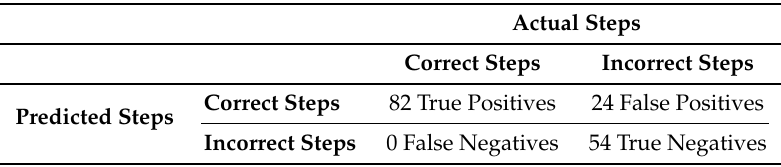
Table 2. Confusion Matrix for the step recognition of side steps.